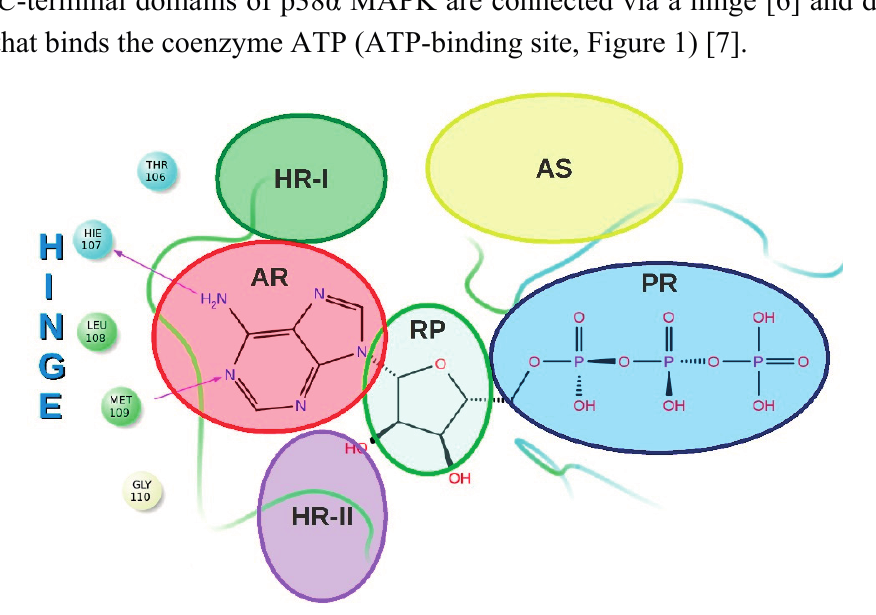
Figure 1. Schematic representation of p38 α MAPK ATP-binding site. Different regions are highlighted using different colors. HR-I: hydrophobic region; HR-II: hydrophobic region II; AR: adenine-binding region; RP: ribose-binding region; PR: phosphate-binding region; AS: allosteric site. Copyright Wiley-VCH. Reproduced with permission from Ref